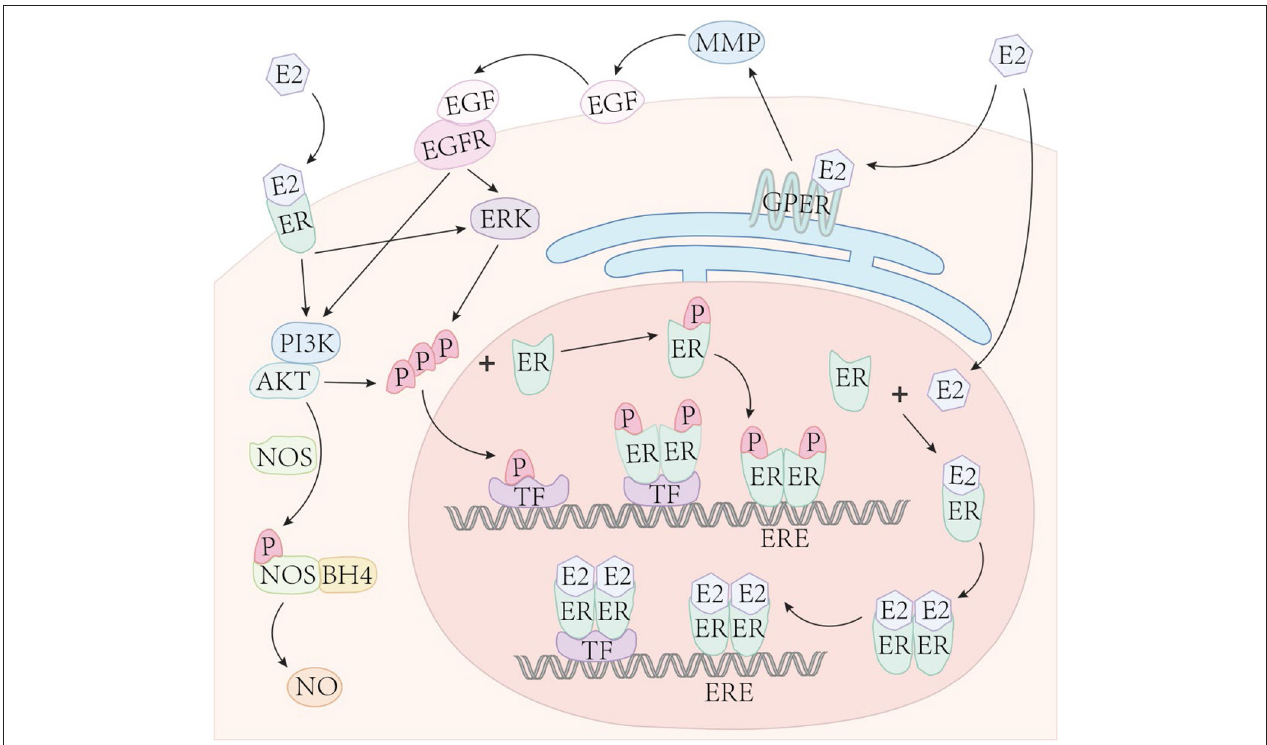
FIGURE 2 | Estrogen signaling. Estrogen enters the cell nucleus and binds with nuclear ERs to form an estrogen-ER complex. The combination of the two estrogen-ER complexes typically lead to dimerization, then bind to DNA in two ways: (1) The estrogen-ER complex directly binds to the ERE sites on DNA and acts as a transcription factor, up- or down-regulating gene expression based on the types of recruited co-regulators; (2) In genes with absent EREs, ER indirectly binds to DNA through other TFs to influence gene expression. Phosphorylated ERs directly binds to ERE or indirectly binds to DNA through TFs, similar to estrogen-ER complexes. Estrogen binds to membrane ER α , Er β , and GPER to mediate non-genomic (acute) estrogen signaling through the activation of various protein kinase cascades.